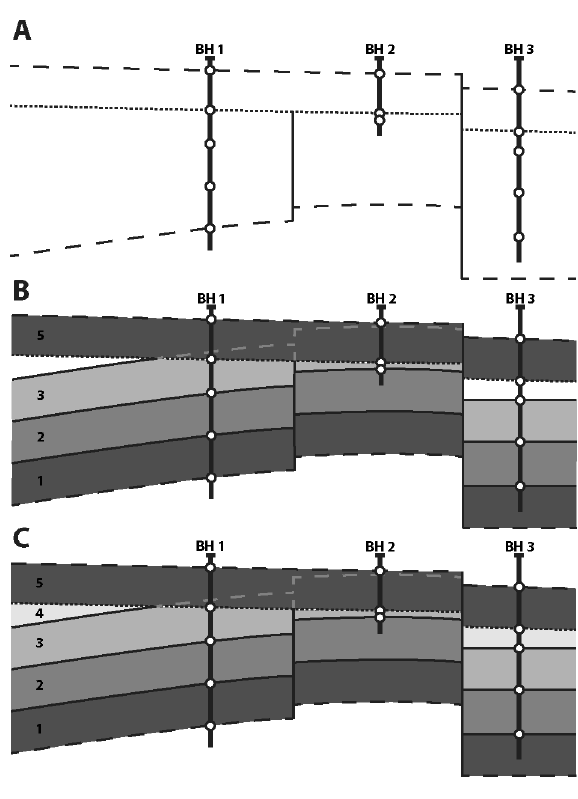
Fig. 1. Schematic drawing of principles for the proposed modelling approach. A , construction of the model framework; B , construction of sedimentary layers with known full thickness; C , construction of sedimentary layers with unknown full thickness. BH 1–BH 3, boreholes with layer boundaries; 1–5, geological layers; vertical lines – faults; dashed lines – base surfaces; dotted line – erosion